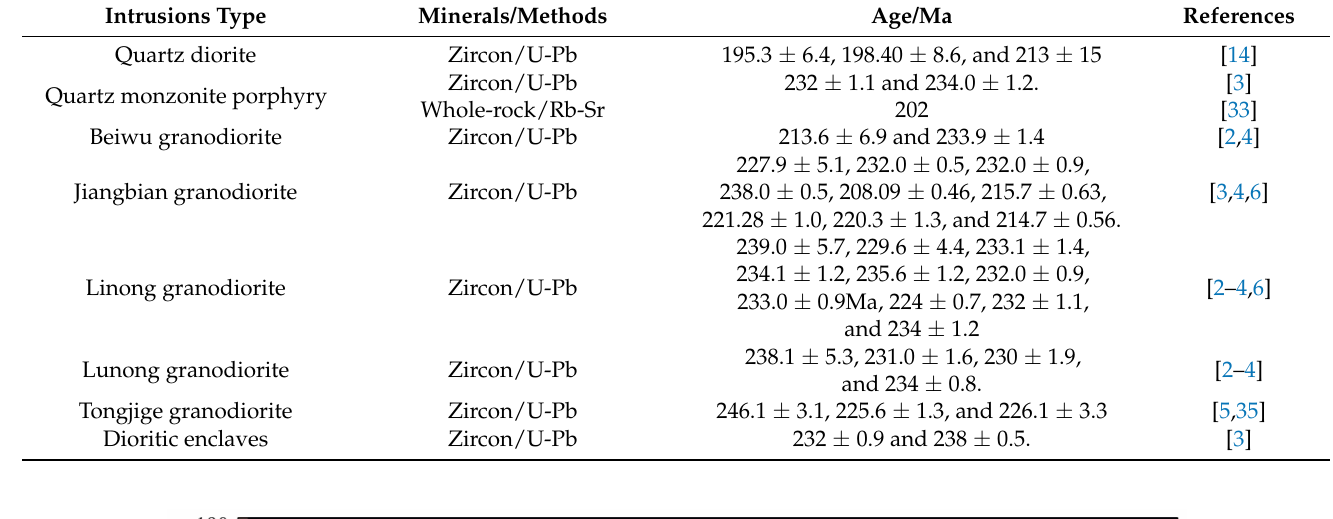
Table 3. The integration of published geochronological data for various granitic plutons in Yangla Cu-W polymetallic deposit.